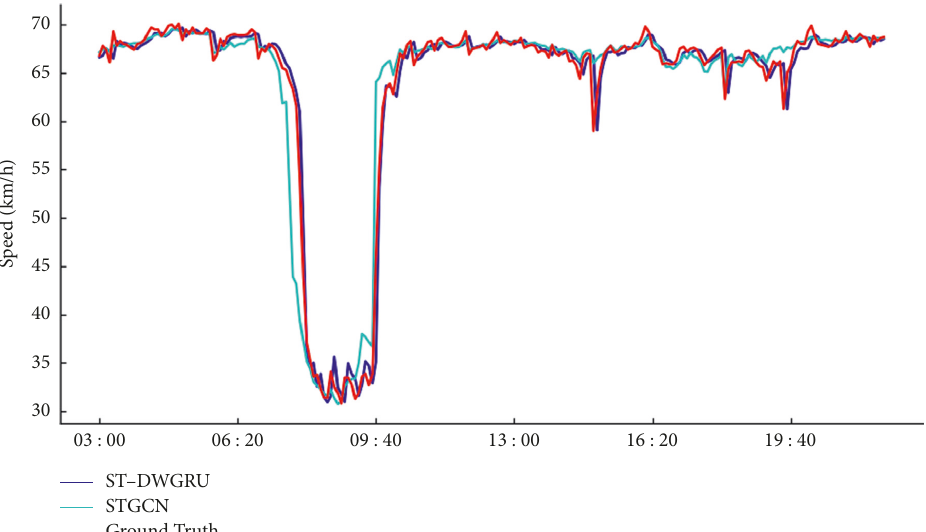
Figure 5: Speed prediction in extreme moments of the dataset PeMSD4.